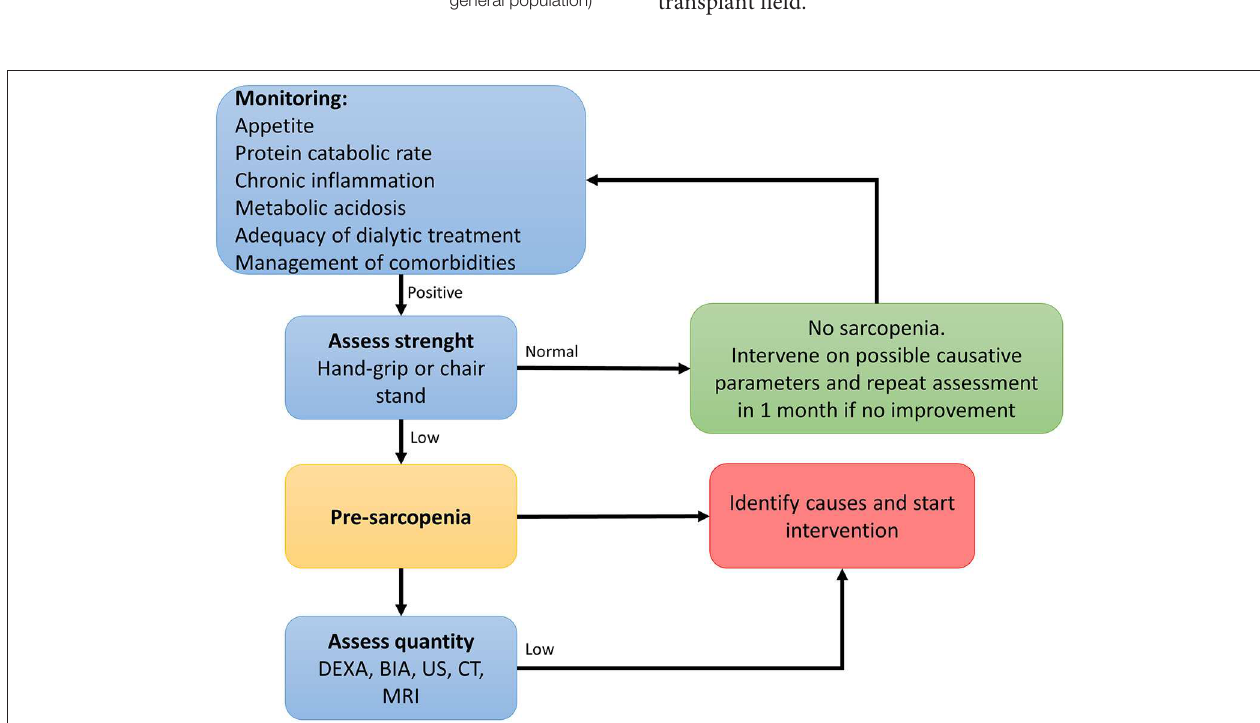
FIGURE 2 | Algorithm to identify cases of sarcopenia in transplant candidates and recipients [adapted from (89)].